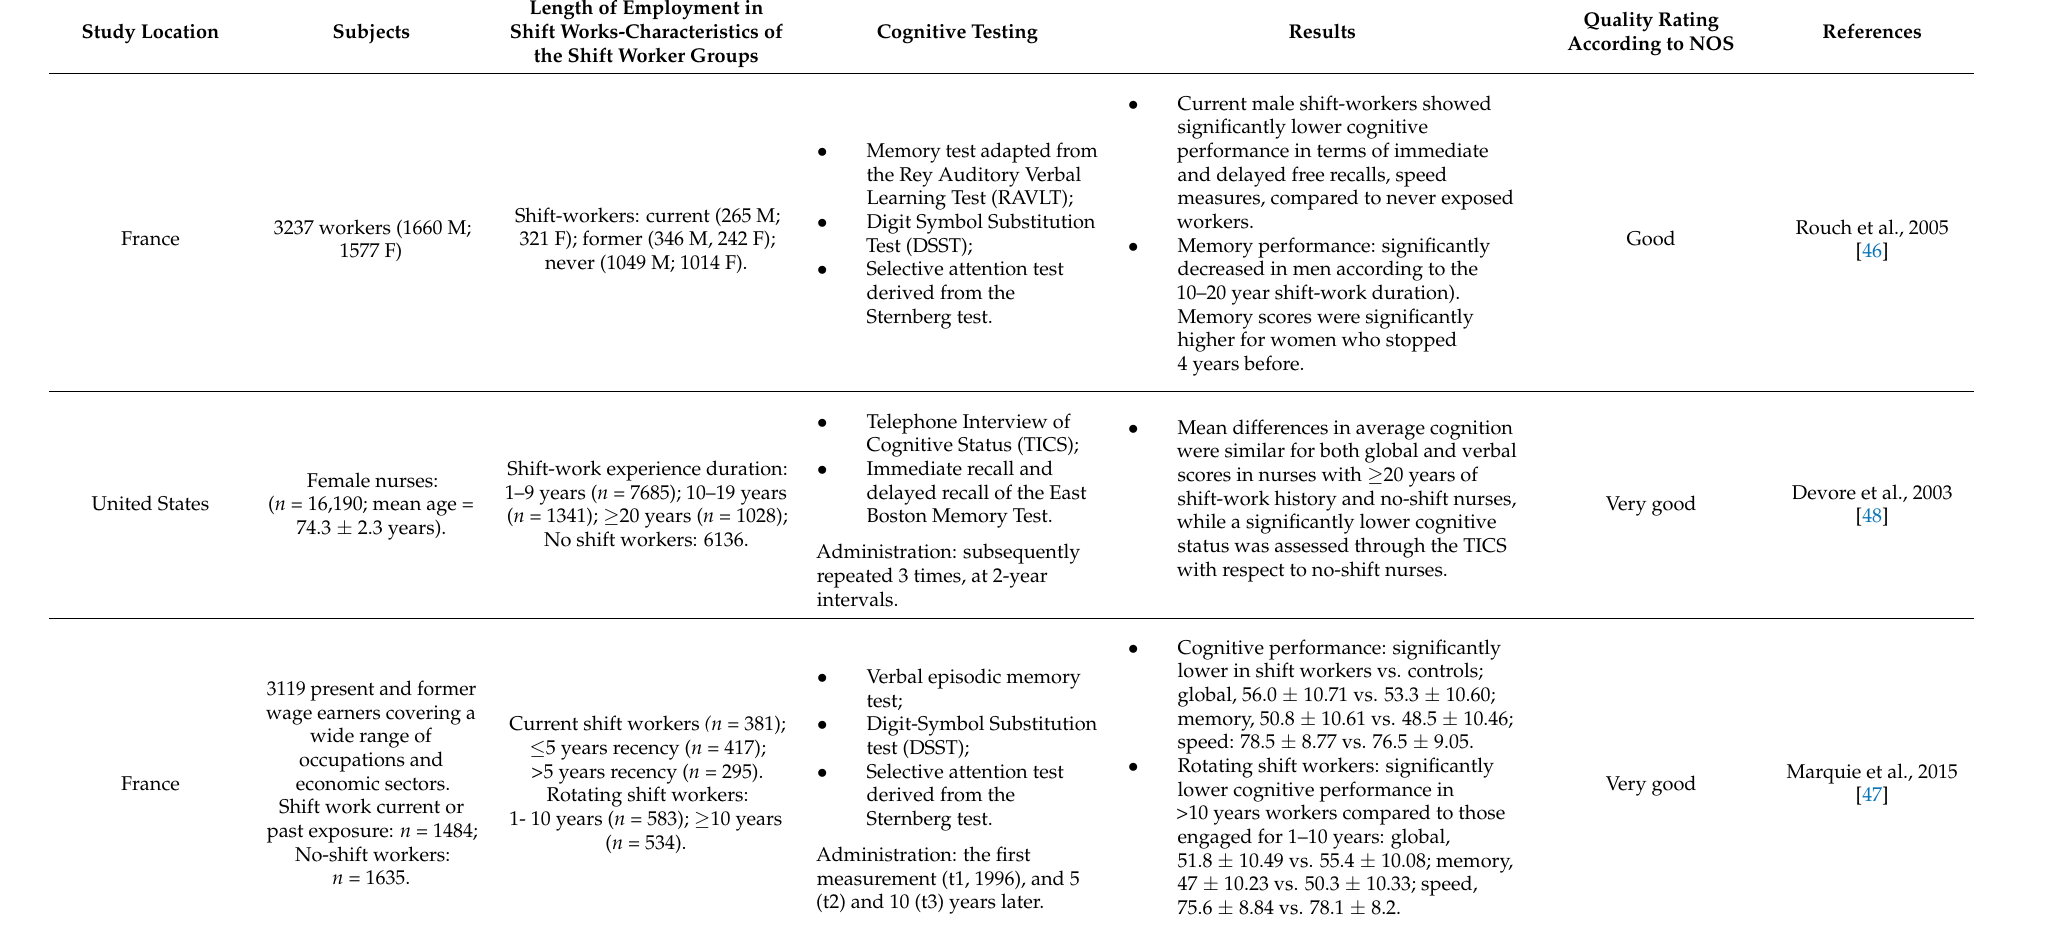
Table 3. Long-term effects induced by shift work on cognitive